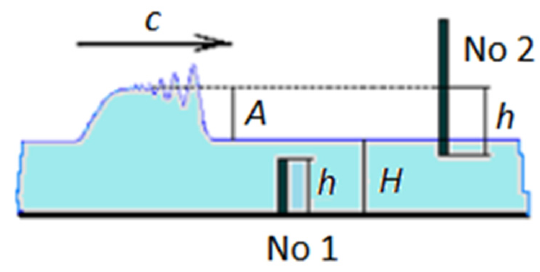
Figure 10. Schematic diagram of the interaction of a tsunami-type wave with impenetrable barriers No. 1 and No. 2.